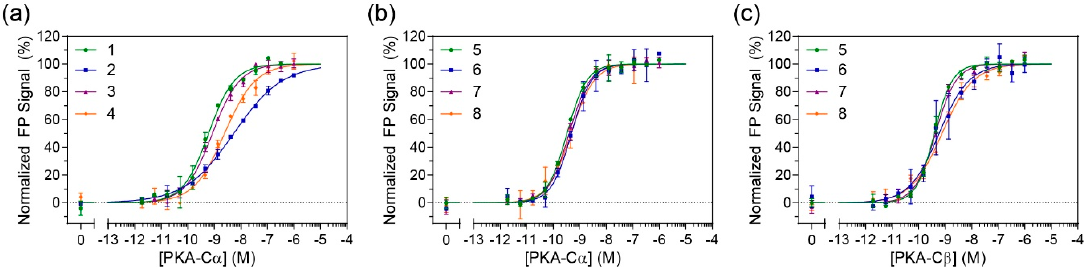
Figure 2. Direct binding measurements of fluorescein-labeled peptides by fluorescence polarization (FP): ( a ) Binding measurements of PKI 5-24 analogs to PKA-C α demonstrate that stapling the 20-residue peptide negatively impacts binding; ( b ) Binding measurements of PKI 1–24 analogs to PKA-C α show no negative e ff ect when stapling the 24-residue peptide; and ( c ) Binding measurements of PKI 1–24 analogs to PKA-C β 1 reveal that the stapled 24-mer analogs also retain high a ffi nity for the C β 1 isoform.